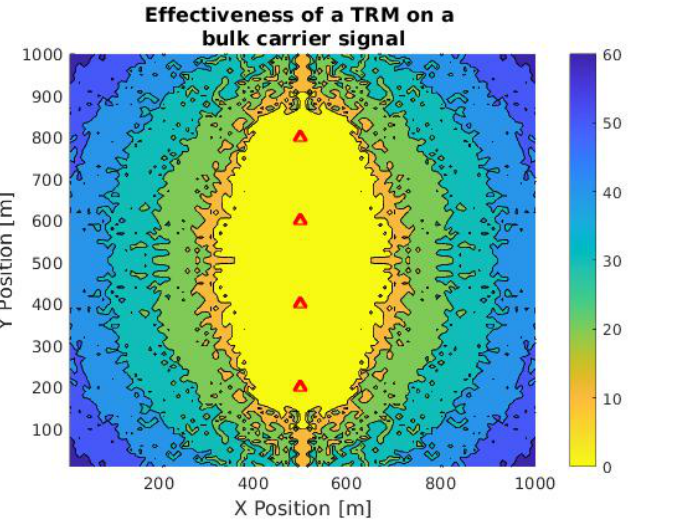
Figure 8. Contour plot of TR calculation accuracy in a TRM in an area of 1 km 2 to the Bulk carrier signal. Red triangles are sensor positions and the color scale is a function of the difference between expected and calculated